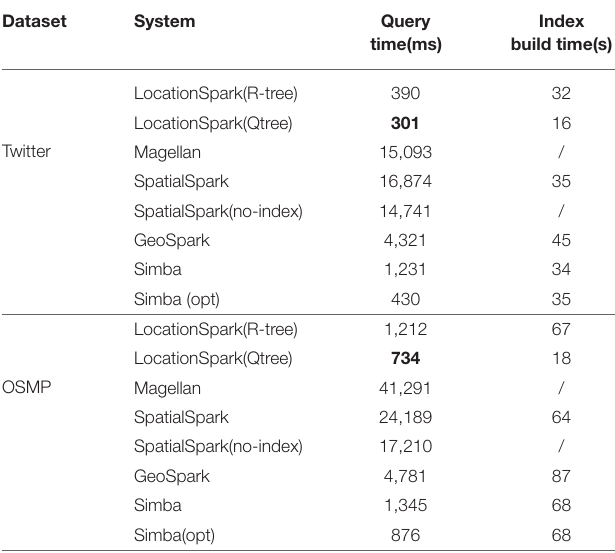
TABLE 1 | Performance of the spatial range select.